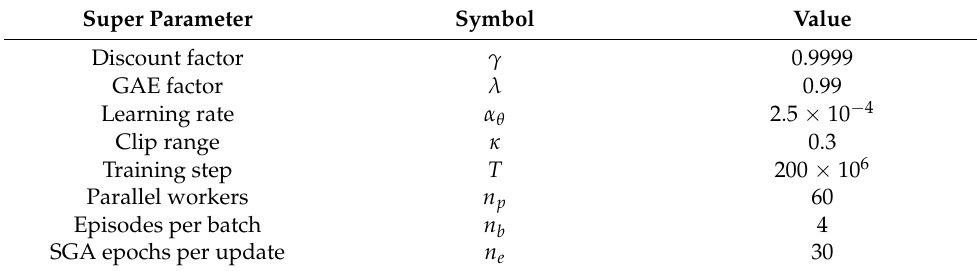
Table 1. Super parameters of the PPO